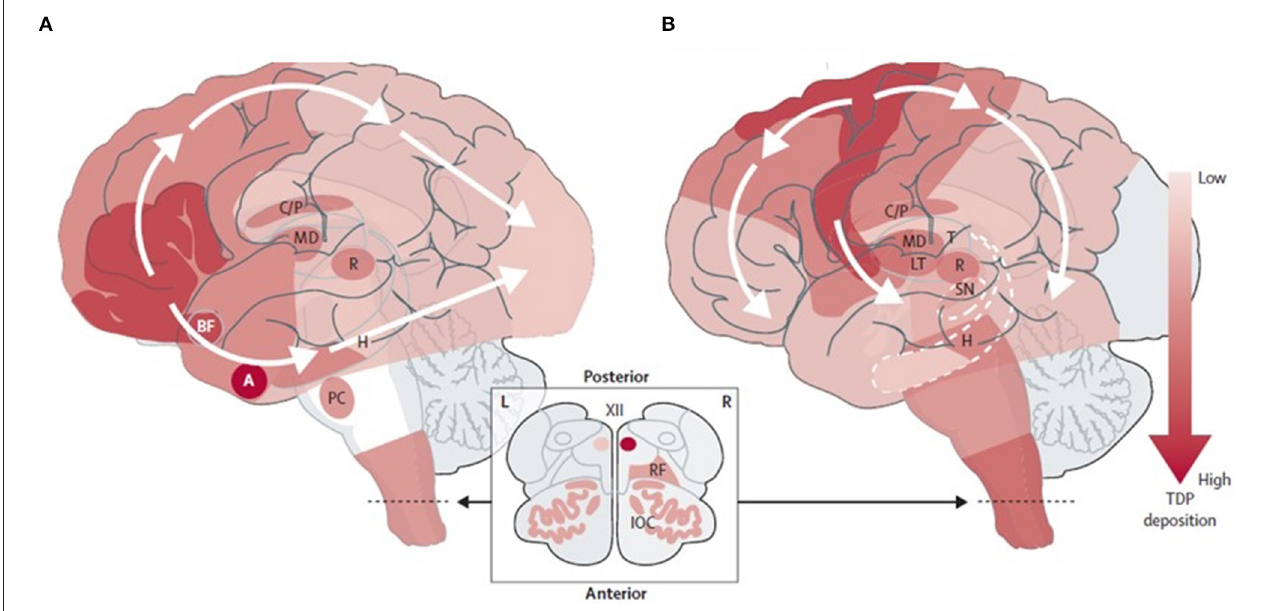
FIGURE 1 | Neuropathological staging schemes in: (A) FTLD-TDP (104) and (B) ALS-TDP (93). Adapted from Burrell et al. (10). FTLD-TDP, frontotemporal lobar degeneration with TAR DNA-binding protein inclusions; ALS-TDP, amyotrophic lateral sclerosis with TAR DNA-binding protein inclusions. BF, basal forebrain; A, Amygdala; H, Hippocampus; PC, precerebellar nuclei; C/P, Caudate nucleus and putamen; MD, Mediodorsal nucleus of the thalamus; T, Thalamus; LT, Lateral thalamus; R, Red nucleus; SN, Substantia nigra; RF, Reticular formation; IOC, Inferior olivary complex; XII, Hypoglossal